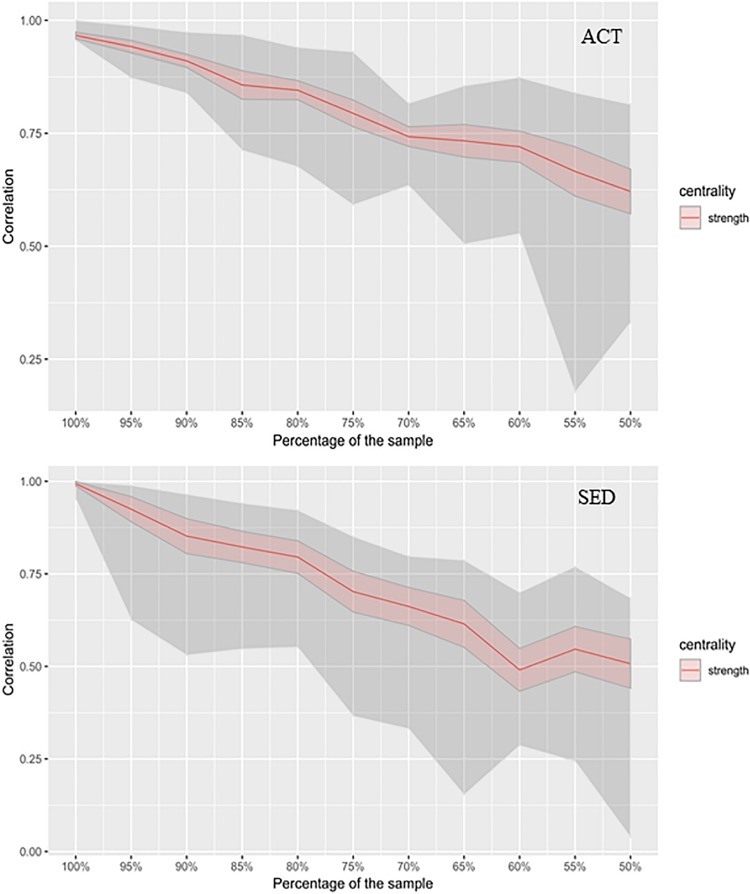
Stability as a measure of how network interpretation remains stable as the number of observations (sample size) decreases. The x-axis represents the percentage of participants considered for the subsamples (ACT and SED), from 100% (whole dataset) to 50% (half of the sample). y-axis represents the stability index measured by the strength of the network. The red area is the confident interval and the gray area is framed by the maximum and minimum values of the stability of the interactions per subsample (extreme values).